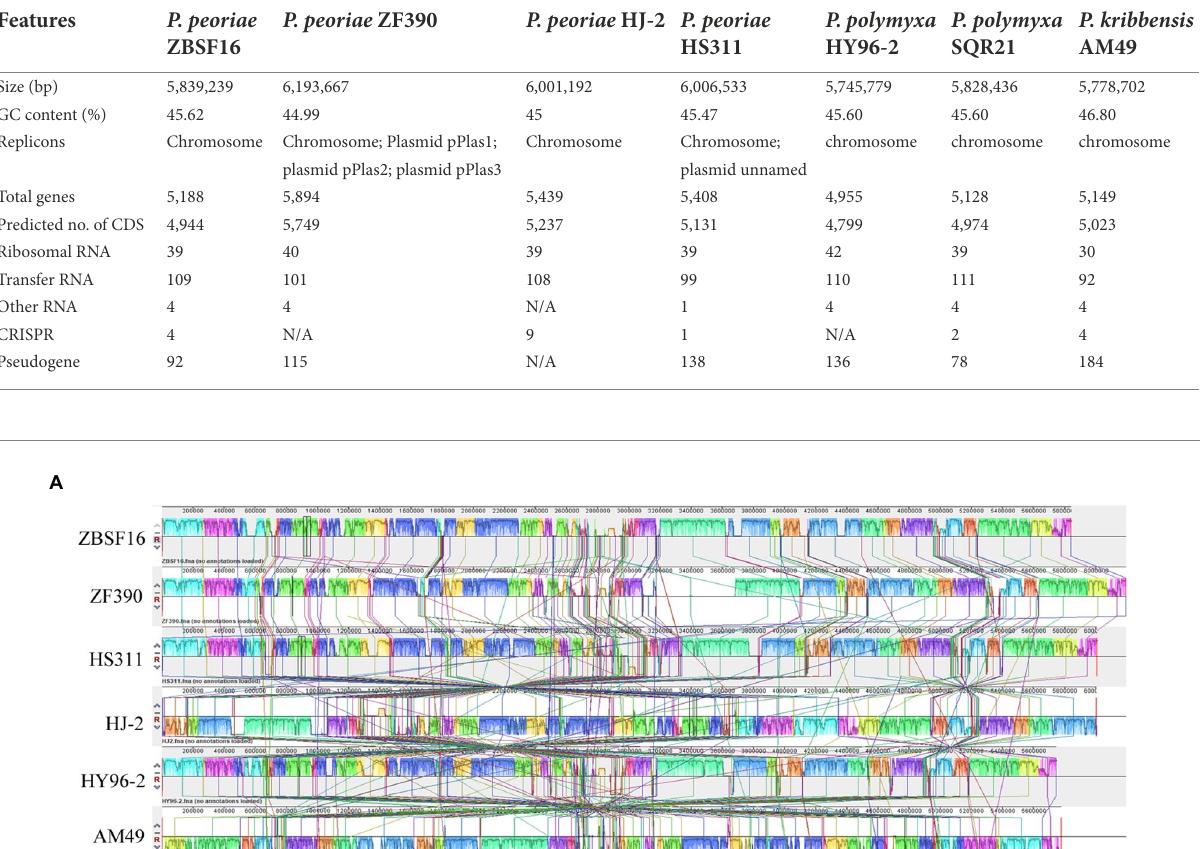
TABLE 1 Genomic features of Paenibacillus peoriae ZBSF16 and other P. peoriae strains.